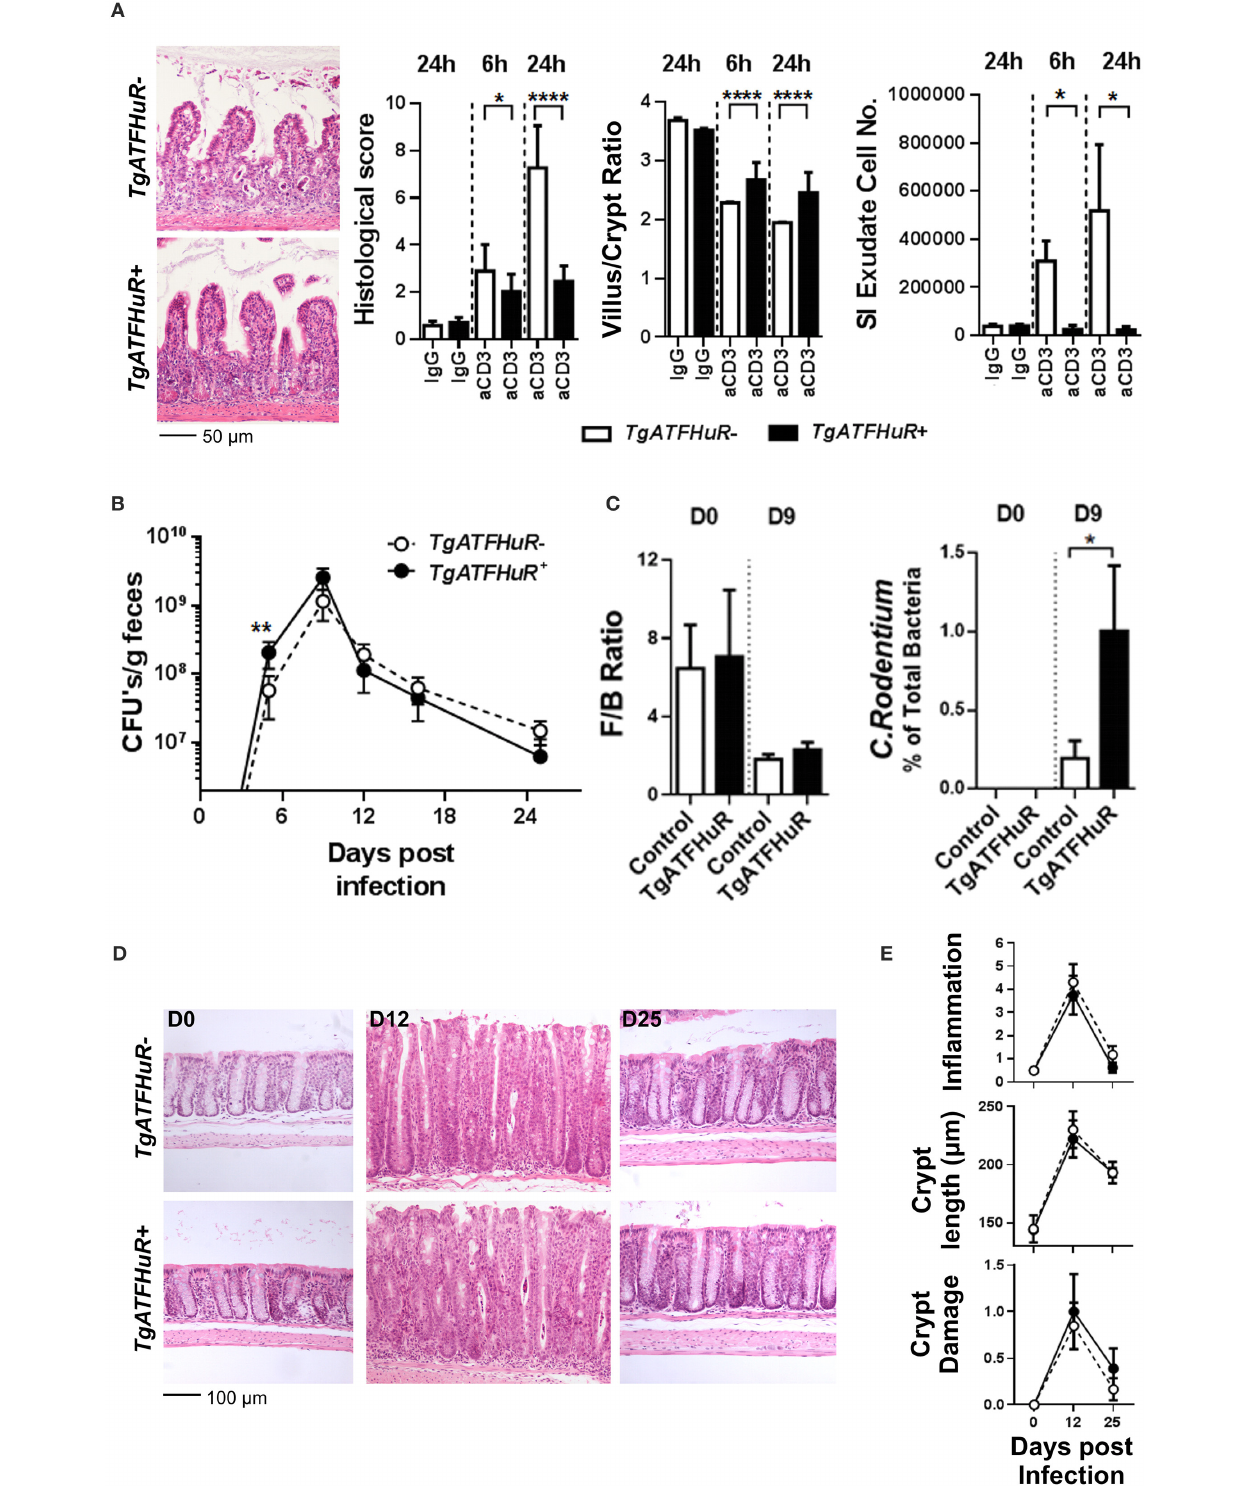
FIGURE 6 | The combinatorial elevation of HuR protects the epithelium from acute inflammatory death signals but compromises inflammatory pathogen clearance. (A) Representative histology (H&E), histological scores, villus/crypt ratio quantification and determination of total cell number in the exudate of the small intestine